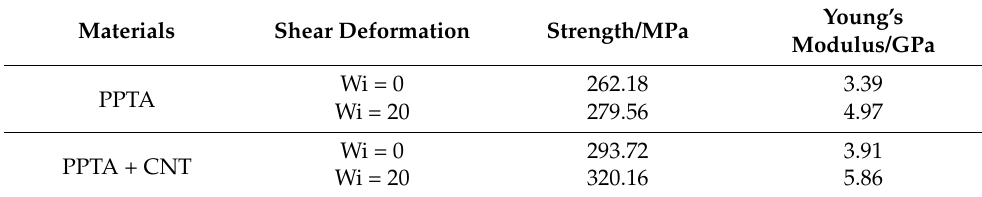
Figure 6. ( a ) Stress–strain curve of different fibers from Molecular dynamics simulation. ( b ) The 3D stress contour in the simulation unit of PPTA-based fibers. Table 1. Mechanical properties of different PPTA